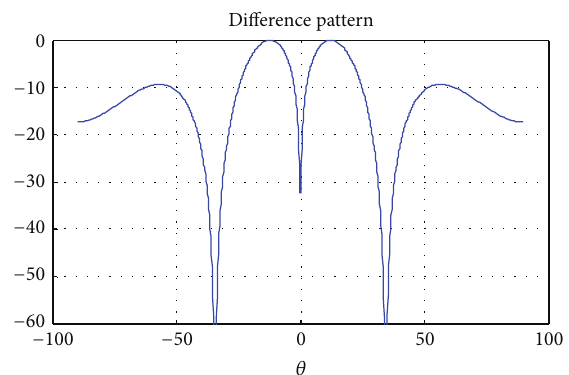
Figure 2: Difference beam pattern for the 10-element linear array for 𝑢 = 1